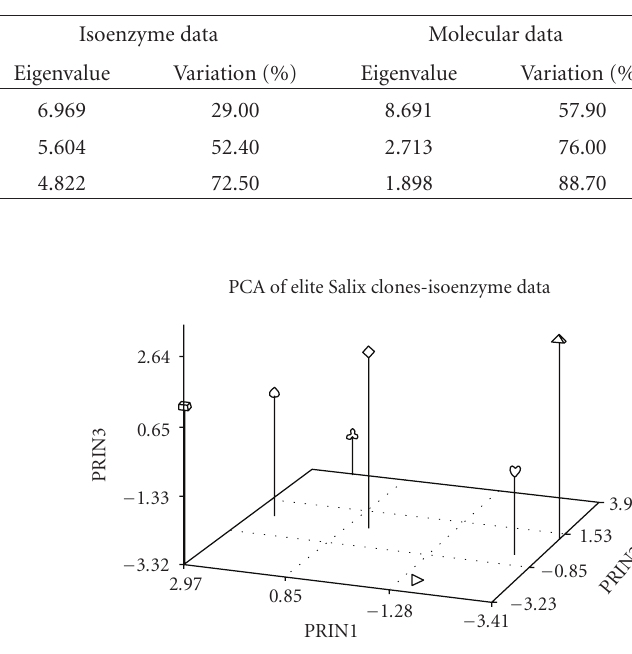
Table 7: Principal component analysis of morphological, isoenzyme, and molecular data of Salix selected clones: eigenvalues and cumulative percent of variation explained by the first three principal components.